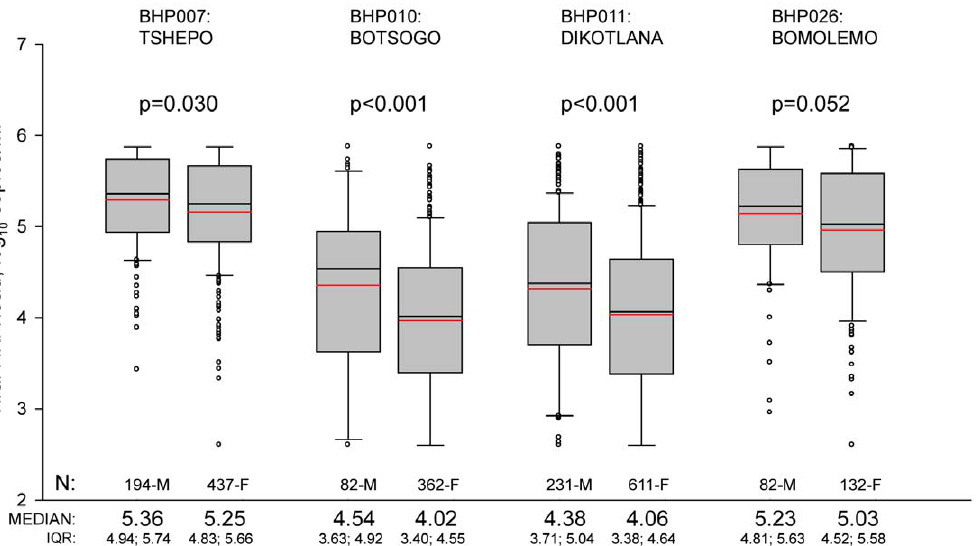
Figure 3. Gender differences in HIV-1 RNA levels in four BHP cohorts (pre-cART baseline data). For explanation of box plots see Figure 1 legend. Text above each box plot indicates the BHP study number and the name of the corresponding cohort. Comparison of HIV-1 RNA levels between genders was performed by the Mann-Whitney Rank Sum test, and p-values are presented above the box plots. Numbers of included male (M) and female (F) participants per cohort are shown at the bottom within the graph. Median and IQR are presented at the bottom outside the graph.